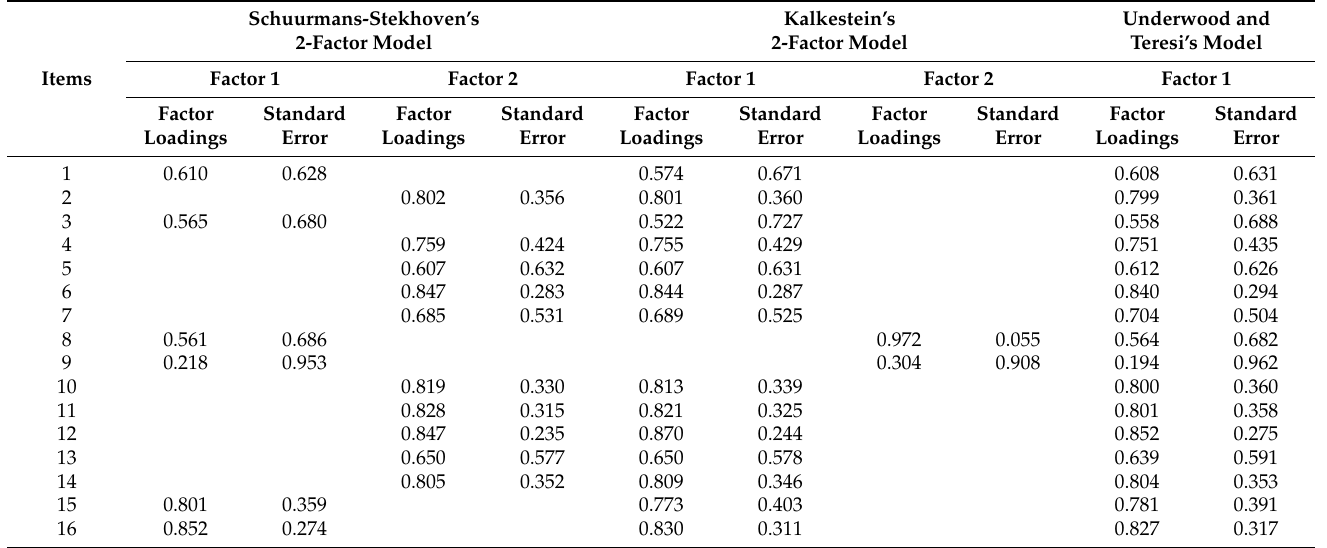
Table 3. Fully standardized factor loadings and standardized errors for the three models under study in Sample 2.